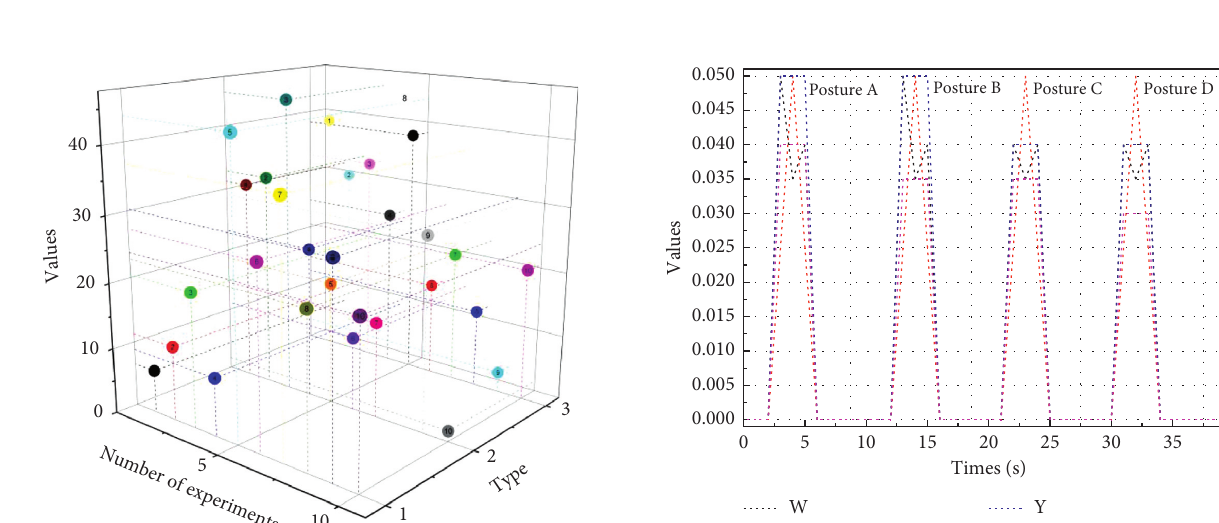
Figure 4: Overall flowchart of motion capture.